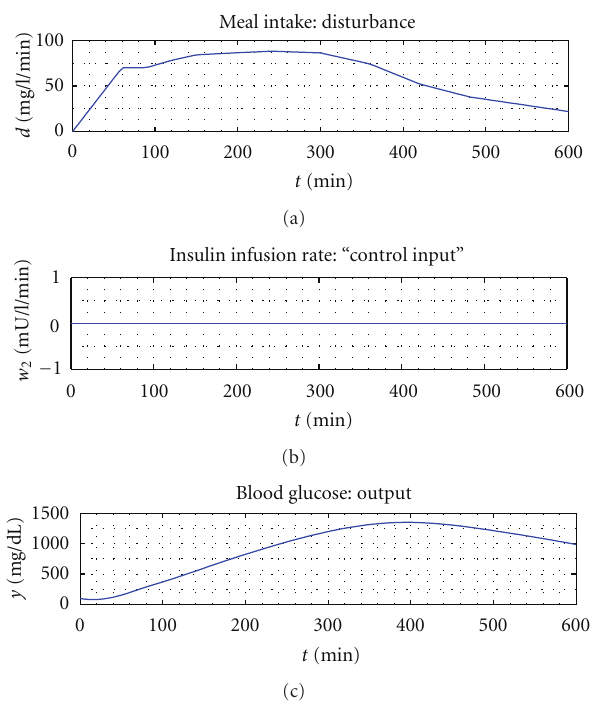
Figure 3: Open-loop simulation results of the modified Liu-Tang model (type 1